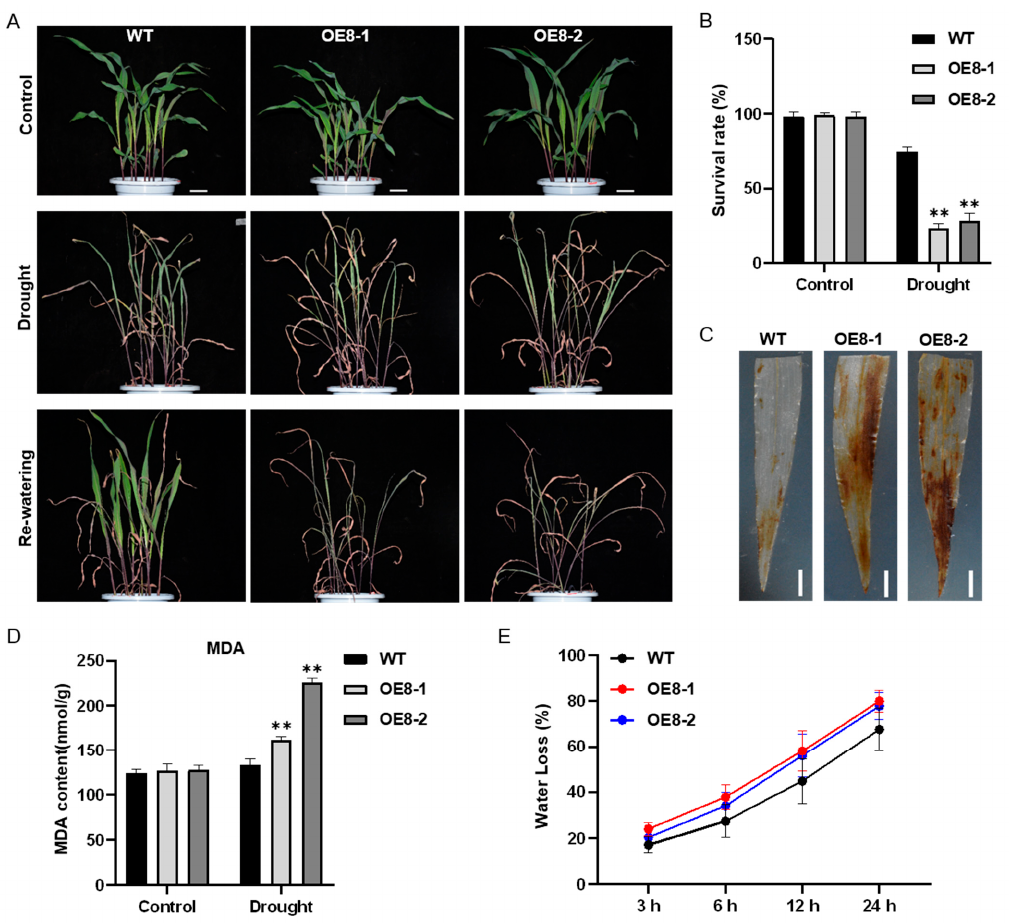
Figure 4. Salt stress tolerance test in the wild-type (WT) and ZmHsf08 -overexpressing plants. ( A ) The phenotypes of WT and ZmHsf08 -overexpressing plants under NaCl treatment. Three-leaf stage maize seedlings were treated with 200 mM NaCl for 2 weeks; the pictures were obtained before or after treatment. ( B ) Expression levels of ZmHsf08 in transgenic maize seedlings were examined by RT-qPCR. ( C ) Survival rate of WT and ZmHsf08 transgenic plants after treatment with 200 mM NaCl for 2 weeks. ( D ) Diaminobenzidine (DAB) staining of the maize leaves after NaCl treatment for 7 days. Bar = 1 cm. ( E ) Malondialdehyde (MDA) content of WT and ZmHsf08 transgenic plants under normal conditions and salt treatment for 7 days. Values are means ± SD. Bars represent means ± SD ( n = 3 repeats). Significant differences (Student’s t test): *, p < 0.05, **, p < 0.01.